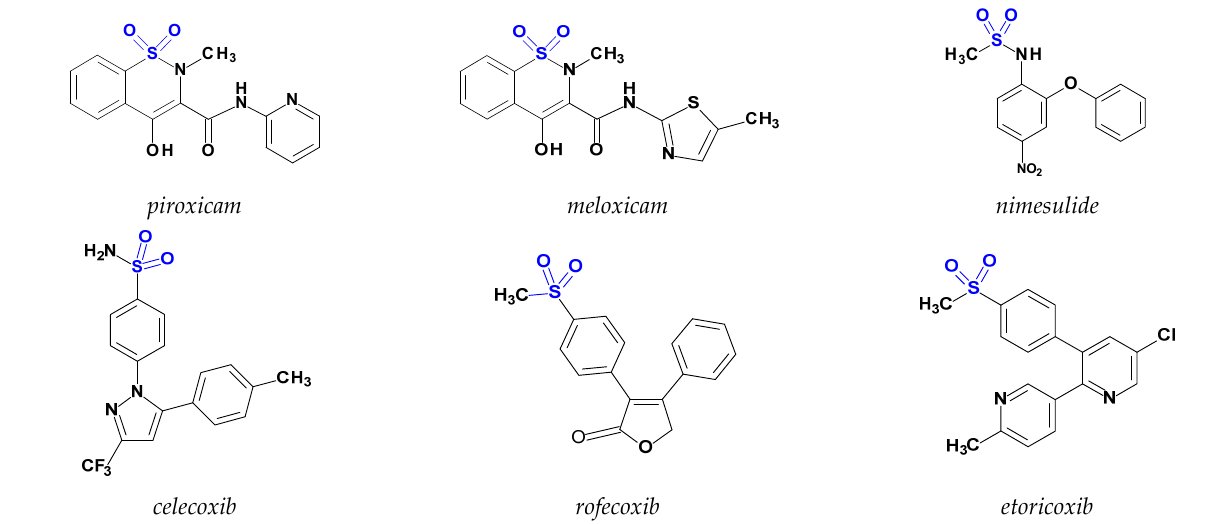
Figure 2. Examples of NSAIDs with the sulfonyl group in their structures.